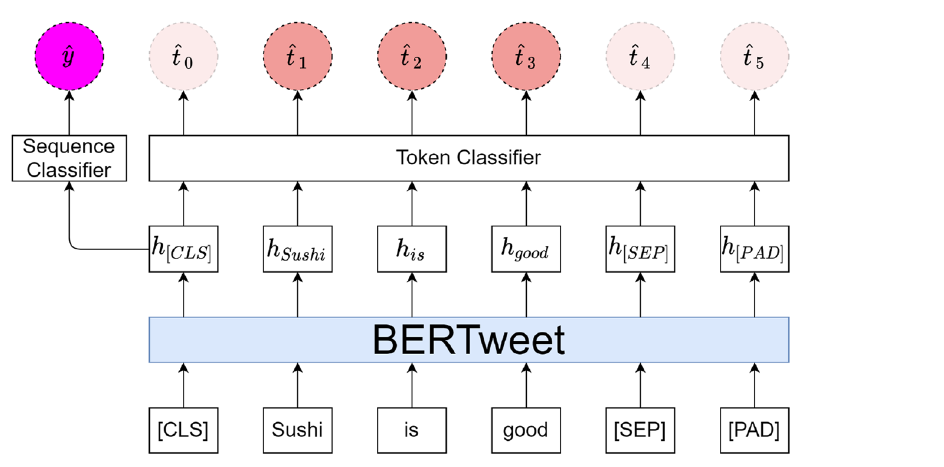
Figure 3. Diagram of the dual-task BERTweet